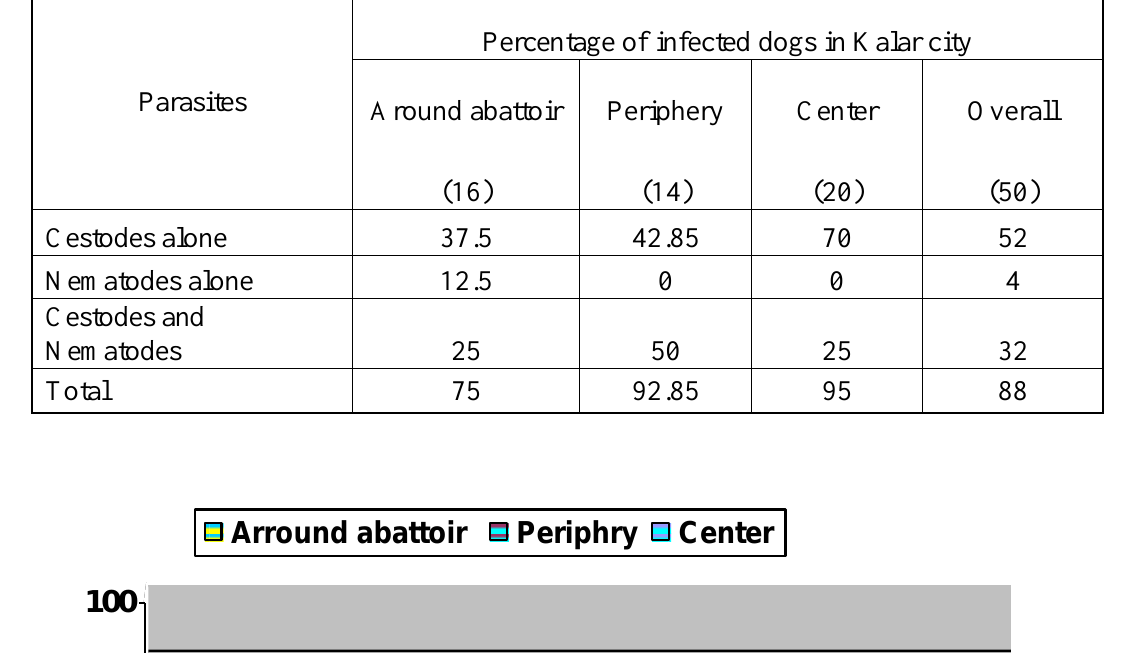
Table 1 Single and concurrent infection of dogs with intestinal helminthic parasites from various regions of Kalar city (number in parentheses indicates number of dogs